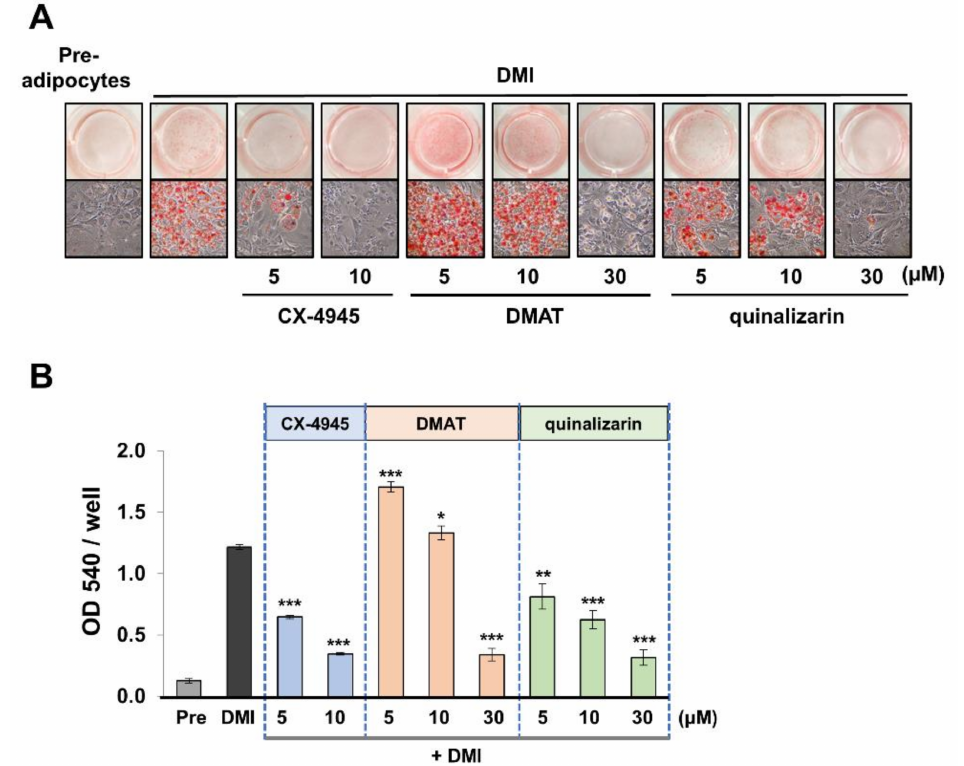
Figure 7. Effect of CK2 inhibitors on the adipocyte differentiation of 3T3-L1 cells. 3T3-L1 cells were treated with CX-4945, DMAT or quinalizarin during adipocyte differentiation and stained with ORO at day 8. ( A ) Microscopic images were acquired, and ( B ) lipid accumulation was assessed by obtaining absorbance at 540 nm. * p < 0.05; ** p < 0.01; *** p < 0.005 vs. DMI vehicle. During the adipogenesis period, the mRNA levels of the Csnk2a1 (CK2 α ) and Csnk2b (CK2 β ), Rock1 and Rock2 genes were all downregulated on day 2, recovered on day 4, and then maintained with small variability (Figure 8A). Compared with mRNA levels, their protein levels were more constant with small changes (Figure 8B,C). In particular, the mRNA level significantly reduced on day 2, whereas the amount of protein showed only minimal